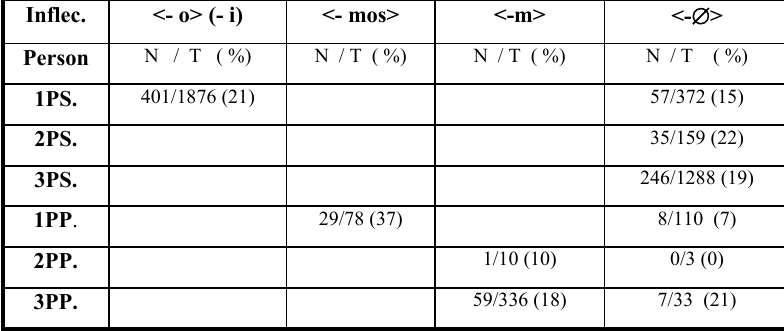
Table IV – Null subjects vs inflection and grammatical person – non-graduates